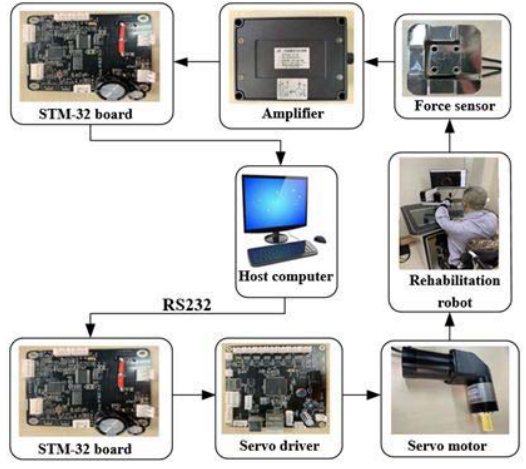
Figure 2. xPC real-time control system.